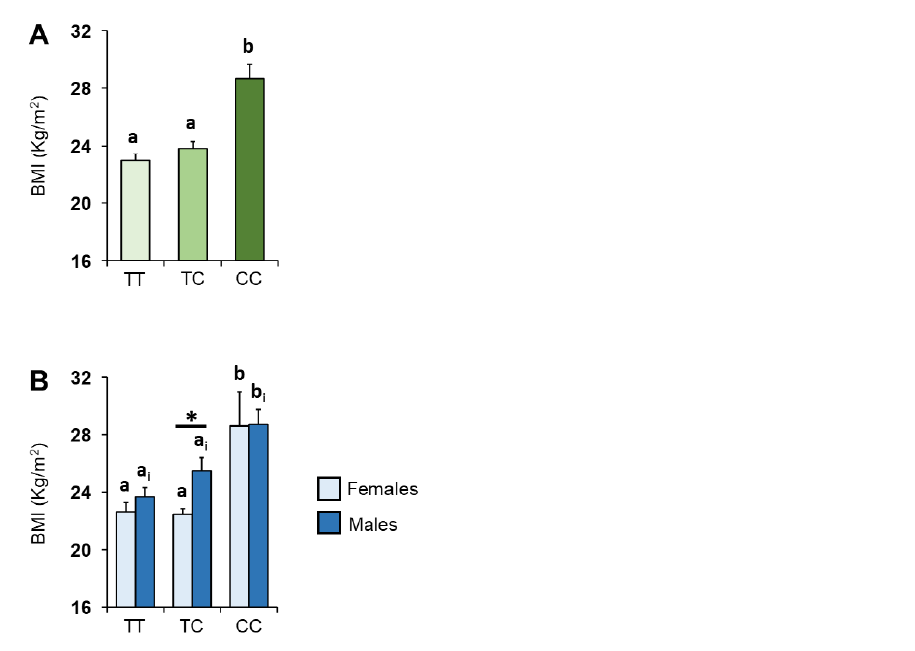
Figure 3. Mean ( ± SEM) values of the BMIs determined in healthy subjects considered all together ( A ) and separately for females and males ( B ) according to genotypes of the Kv1.3 locus. ( A ) Different letters indicate a significant difference ( p < 0.0001; Fisher’s LSD test). ( B ) Different letters indicate a significant difference: a – b for females ( p < 0.0005; Fisher’s LSD test), a i – b i for males ( p < 0.05; Fisher’s LSD test). Asterisk indicates a significant difference between females and males with the same genotype ( p = 0.005; Fisher’s LSD test). (*) indicates significant differences between females and males with the same genotype ( p < 0.01; Fisher’s LSD test). Genotype distributions and allele frequencies for the rs2821557 ( T/C ) polymorphism of the Kv1.3 gene according to BMI status are shown in Table 2. The results indicate that significant differences, based on the genotype distribution and allele frequencies of the Kv1.3 locus, also existed when the subjects were classified as normal weight (NW) or over- weight (OW) by means of their BMI (Genotype: NW χ2 = 9.46, p = 0.0088; OW χ2 = 31.89, p < 0.0001. Allele frequency: NW χ2 = 10.40, p = 0.0055; OW χ2 = 31.88, p < 0.0001; Fisher’s method). Table 2. Genotype distribution and allele frequencies of the rs2821557 polymorphism of the Kv1.3 gene ( T/C ) in the subjects classified as normal weight or overweight on the basis of their BMI. Normal Weight Overweight BMI p -Value n (%) n (%) Allele Genotype 35 (58.33)